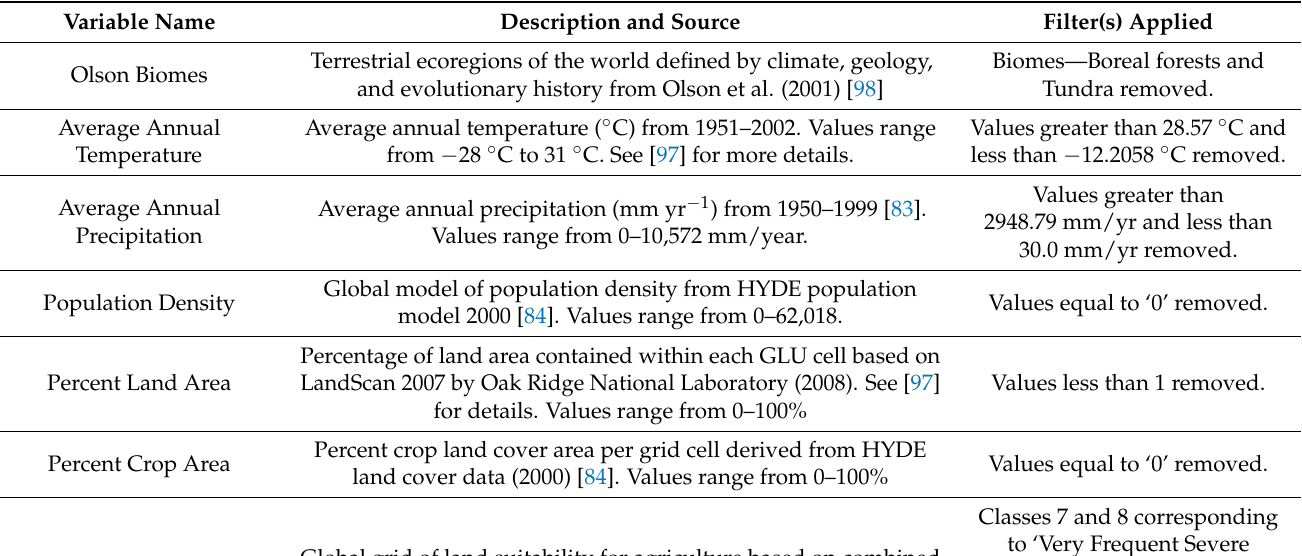
Table 2. Description of all the filters applied to the GLU layer obtained from